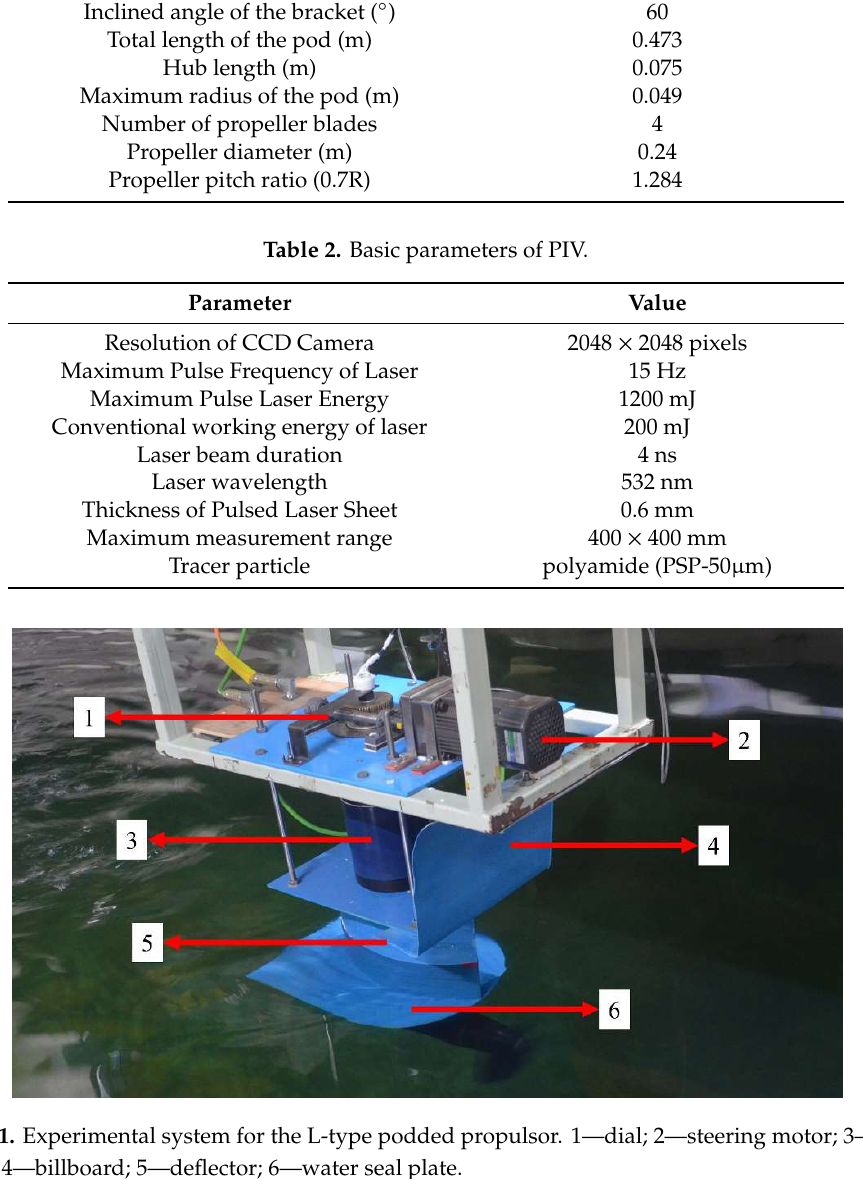
Figure 2. Stereoscopic towing tank particle image velocimetry (PIV) probe and laser. Table 2. Basic parameters of PIV. Parameter